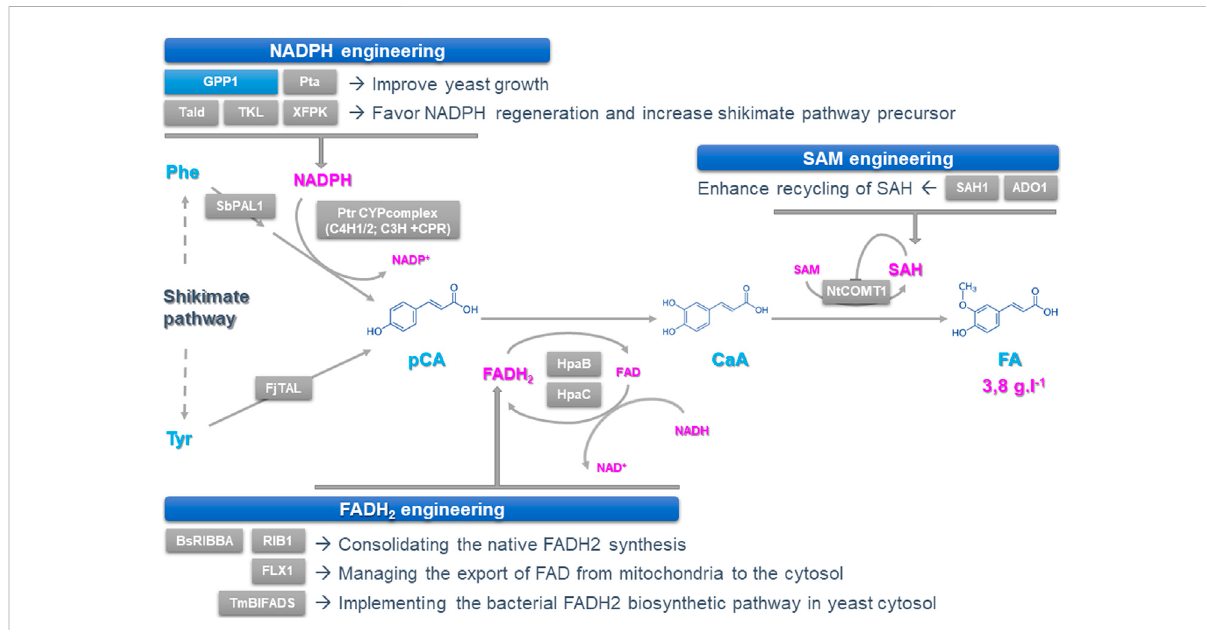
FIGURE 1 Improving the synthesis and regeneration of cofactors to increase the synthesis of podophyllotoxin precursors in yeast. Podophyllotoxin biosynthesiscanbe achievedthroughathree-step routeinvolving deamination oftyrosine and phenylalanine to formp-coumaric acid (pCA), which is then hydroxylated and O -methylated to from caffeic acid (CaA) and ferulic acid (FA), respectively. Each step catalyzed by heterologous enzymes requires cofactors including NADPH, FAD (H 2 ) and SAM whose supplies have been engineered by optimizing their synthesis and/or recycling. Overexpressed and deleted genes are indicated with grey and blue boxes respectively. ADO1: Adenosine kinase; BsRIBBA: Bacillus subtilis bifunctional DHBP synthase/GTP cyclohydrolase II; CaA: Caffeic Acid; CPR: Cytochrome P450 Reductase; FA: Ferulic Acid; FAD (H2):